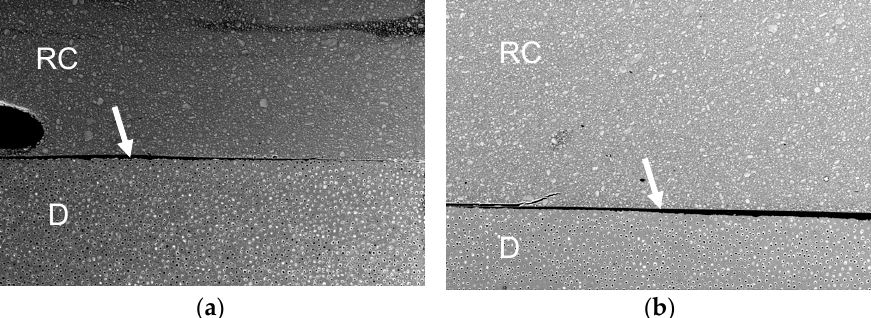
Figure 2. Backscatter SEM images of the resin–dentin adhesive interfaces of PBE after 24 h. ( a ) Re- ceived by the manufacturer; ( b ) expired. RC, resin composite. D, dentin. White arrows indicate ad- hesive layer; 250x.